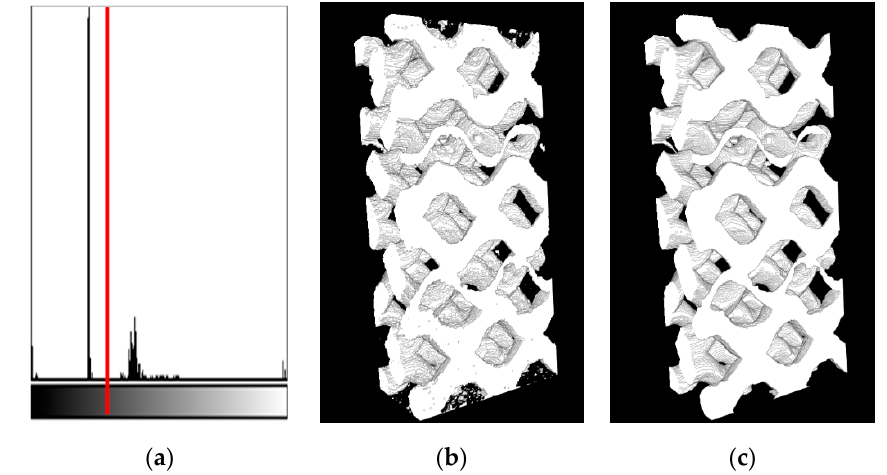
Figure 6. Postprocessing of Mumford–Shah functional minimization result (the illustrations correspond to Figure 5d): ( a ) The image histogram with red line threshold; ( b ) The thresholding result, and ( c ) cleaned result. Algorithm 3: Variational Segmentation.